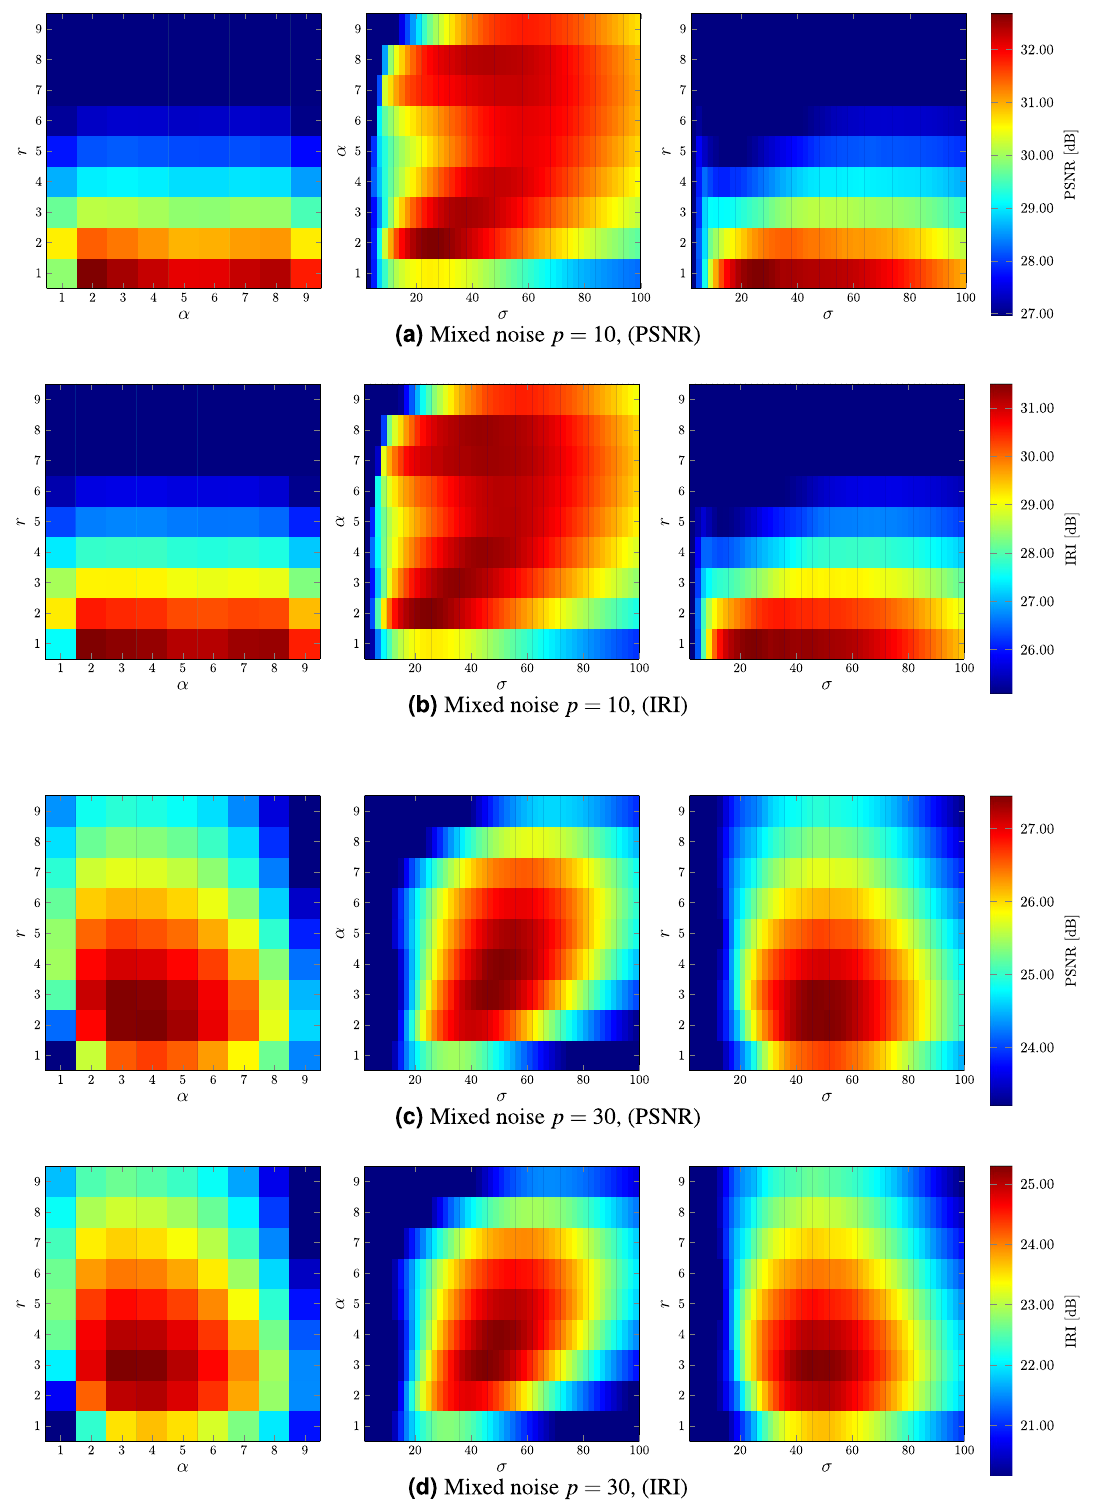
Figure 5. Dependence of highest achievable PSNR and IRI values on r , α and σ parameters for image PEPPERS corrupted with mixed noise of intensity p = 10 ( a , b ) and p = 30 ( c , d